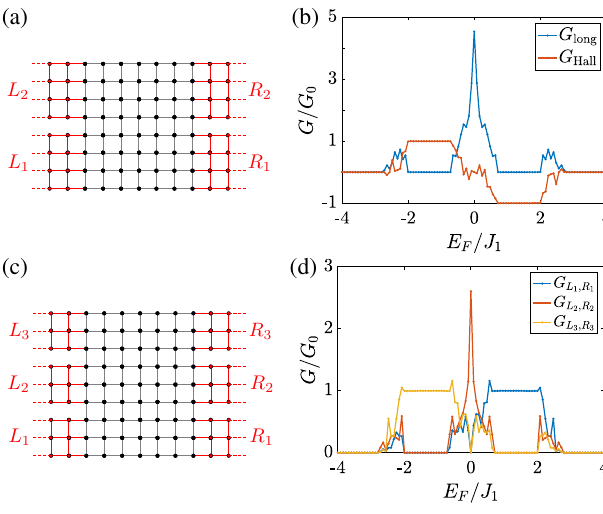
ˆ V ð t Þ is applied FIG. 6. (a) Effective four-terminal geometry and (b) the result- ing longitudinal and Hall conductances. (c) Effective six-terminal geometry and (d) the resulting conductances G L